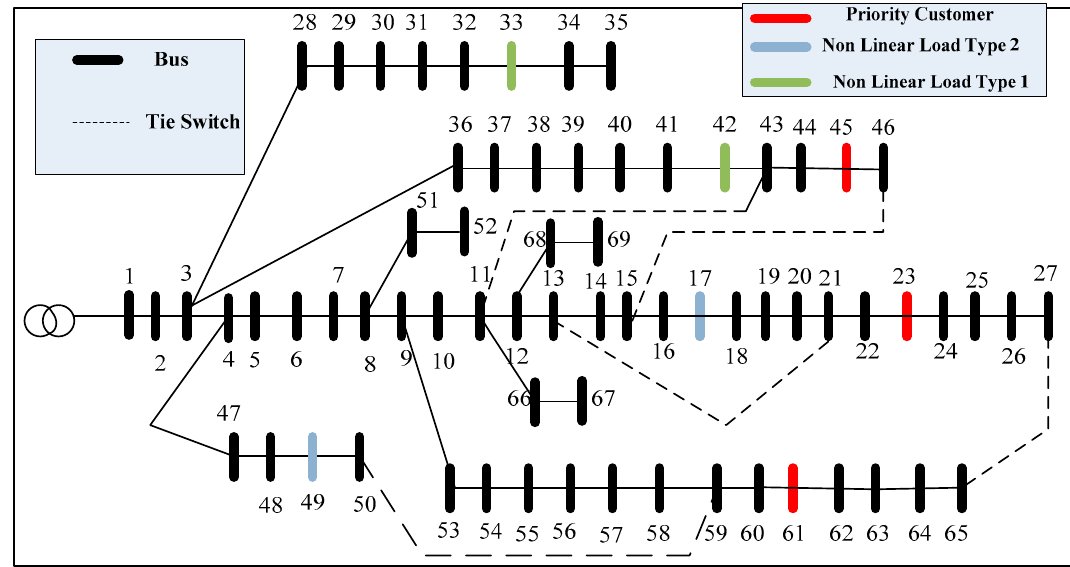
Figure 10. IEEE 69 bus test system.